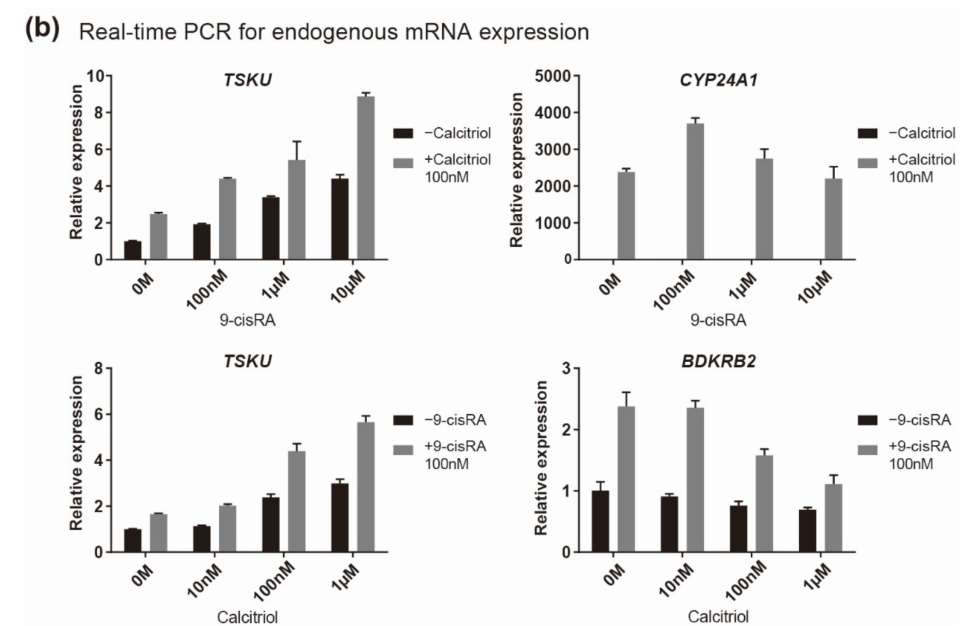
Figure 6. Responsiveness in the case of co-existence of vitamin A (9-cisRA) and vitamin D (calcitriol). A quantitative analysis was performed using two assays when the concentration of 9-cisRA was increased in the absence or in the presence of calcitriol and vice versa. ( a ) Luciferase assay of the indicated reporter cell clone in which the gene indicated in parentheses responded and ( b ) real-time PCR analysis of the endogenous expression of the indicated mRNA. The plots are the mean from three independent experiments with three measurements each. Error bars indicate